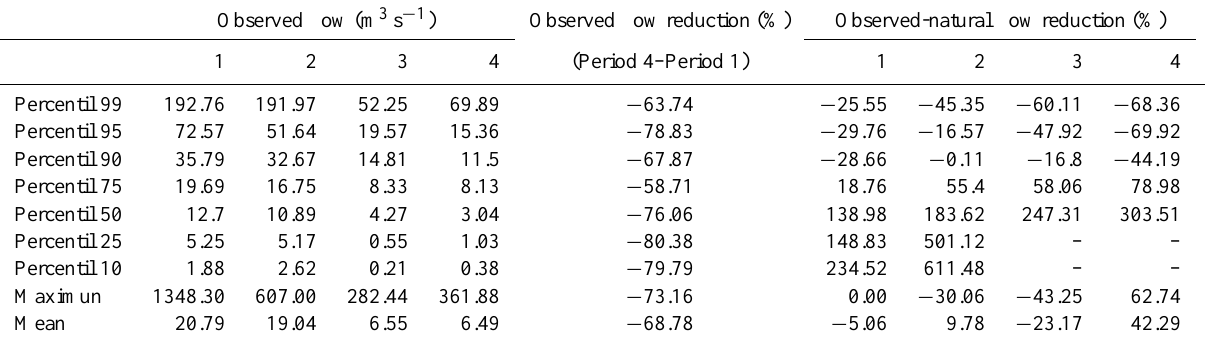
Table 3. Statistical values of daily mean observed flow for the final stretch of Guadalete River, on the confluence of the two main channels. 1–4 are period with different storage capacity: 1000hm 3 (73%), 1135hm 3 (83%), 1149hm 3 (84%) and 1372hm 3 (100%), corresponding positive sign: